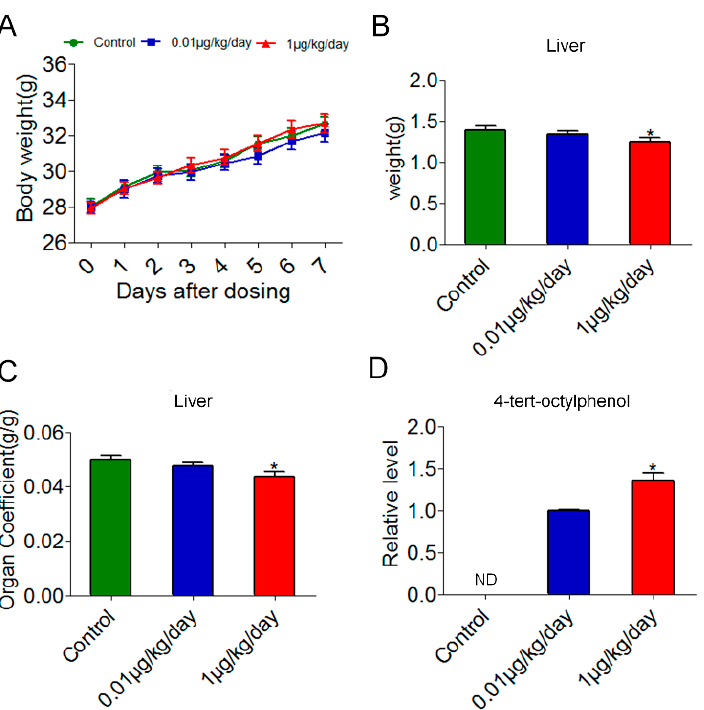
Figure 1. Effects of low-dose 4-tert-octylphenol (OP) on body weight, weight of liver and liver organ coefficient as well as OP blood serum level in mice. ( A ) Body weights of mice were not significantly changed between the control and OP-treated groups. Values are mean ± SEM. ( B ) Weight of liver was decreased significantly in the OP (1 µ g/kg/day) group. Values are mean ± SEM. Significance level: * p < 0.05 compared with controls. ( C ) Organ coefficient of liver was decreased significantly in the OP (1 µ g/kg/day) group. Values are mean ± SEM. Significance level: * p < 0.05 compared with controls. ( D ) The blood serum level of OP in the OP (1 µ g/kg/day) group was significantly higher than that in the OP (0.01 µ g/kg/day) group, and OP was undetectable in the control group. ND: Not detectable. Significance level: * p < 0.05 compared with the OP (0.01 µ g/kg/day) group using t -test.